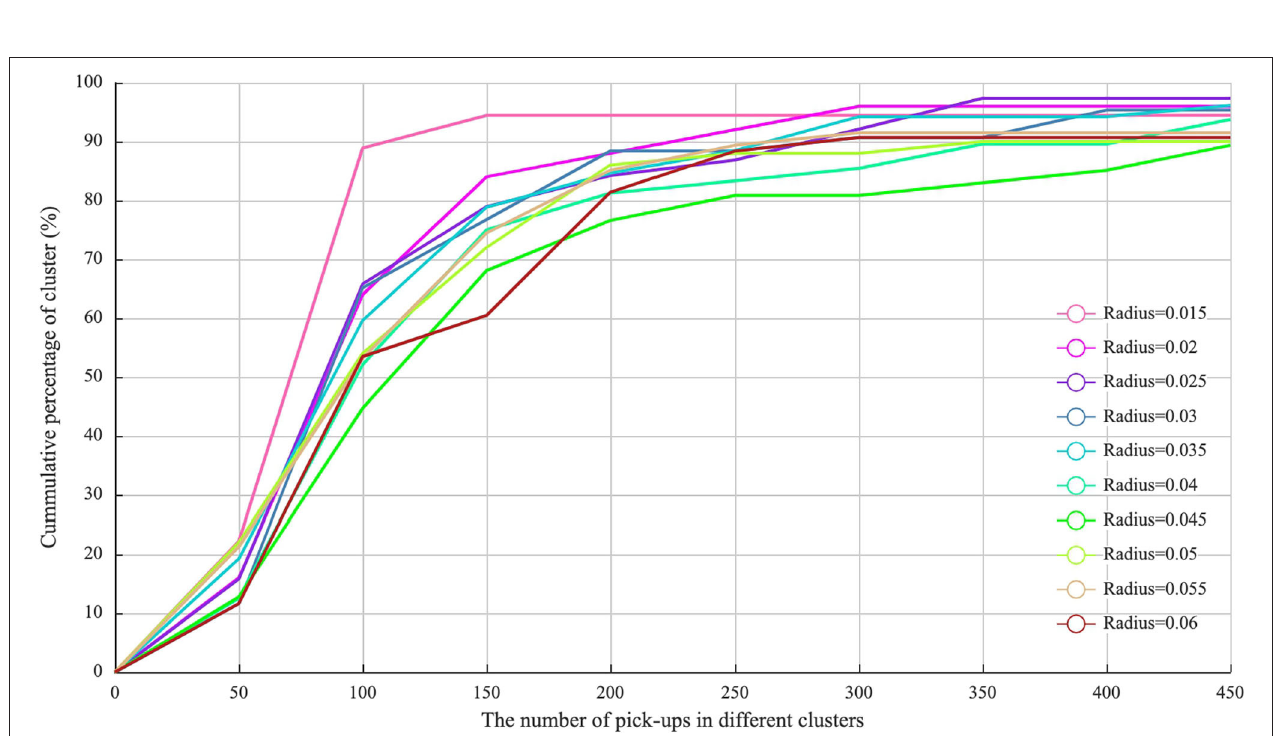
FIGURE 6 | The reachability plot for the data set of pick-ups in peak hours.